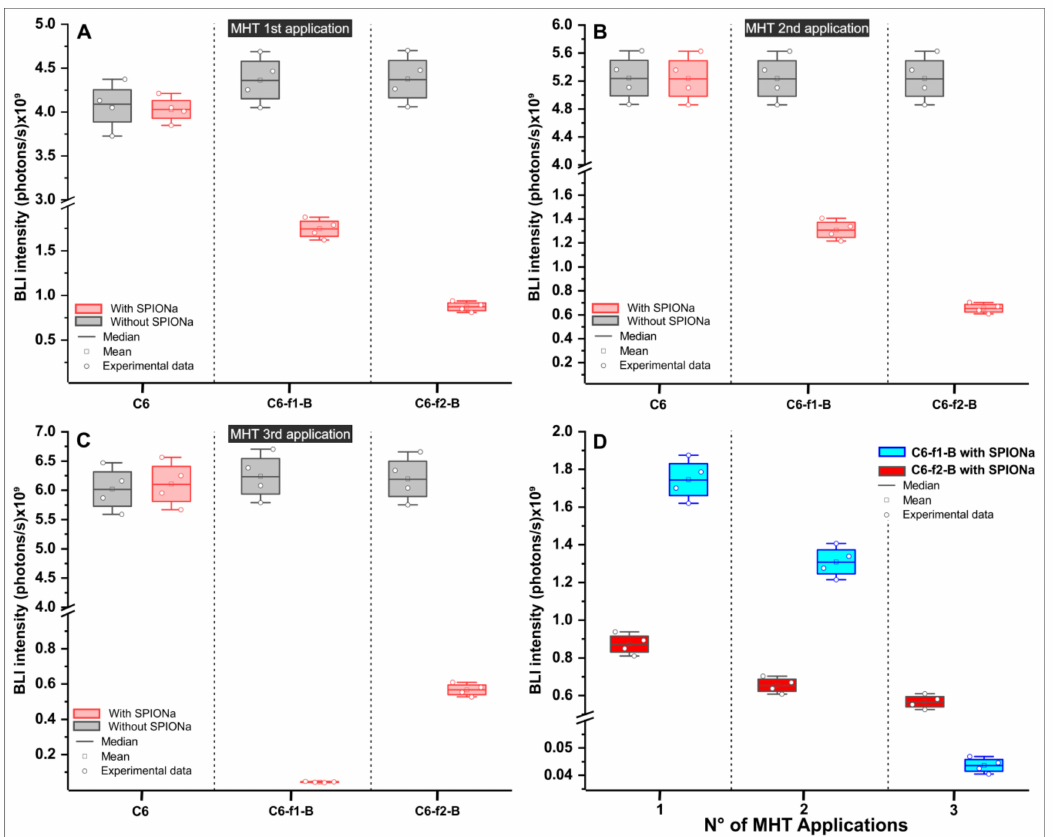
Figure 5. Comparison of BLI signal intensity between groups with and without SPIONa in the MHT multiple applications. The box plot shows the BLI intensity in the experimental groups ( A ) after one MHT application, ( B ) after two MHT applications, ( C ) after three MHT applications, and ( D ) the comparison of BLI intensities between the therapeutic groups, analyzing the two sets of AMF configuration: (f1-B e f2-B f1 = 309 kHZ; f2 = 557 kHz e B = 300